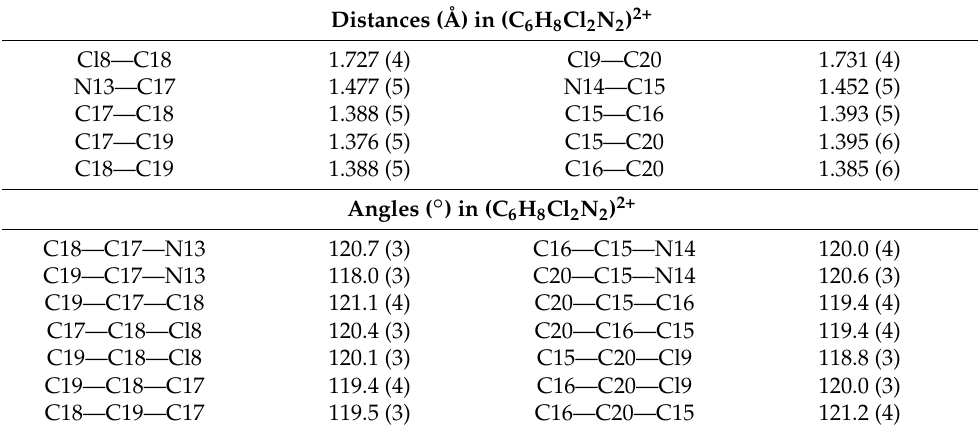
Table 3. Geometric feature of (C 6 H 8 Cl 2 N 2 ) 2+ in (C 6 H 8 Cl 2 N 2 ) 2 [Cd 3 Cl 10 ] · 6H 2